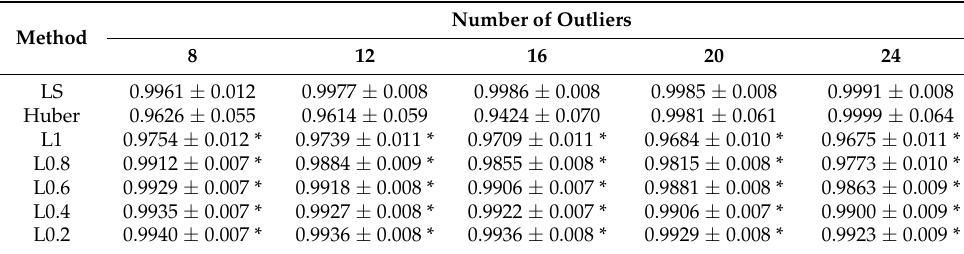
Figure 1. The output and input waveforms mingled with outliers. ( a ) The system input. ( b ) The system output. Table 1. Parameter estimation bias of the single-input–single-output (SISO) system with different numbers of